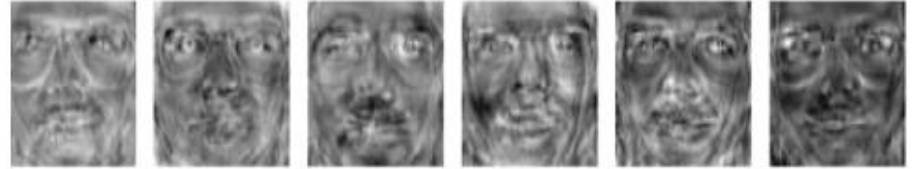
Figure 11. The first five Fisherfaces obtained from the ORL database [63].